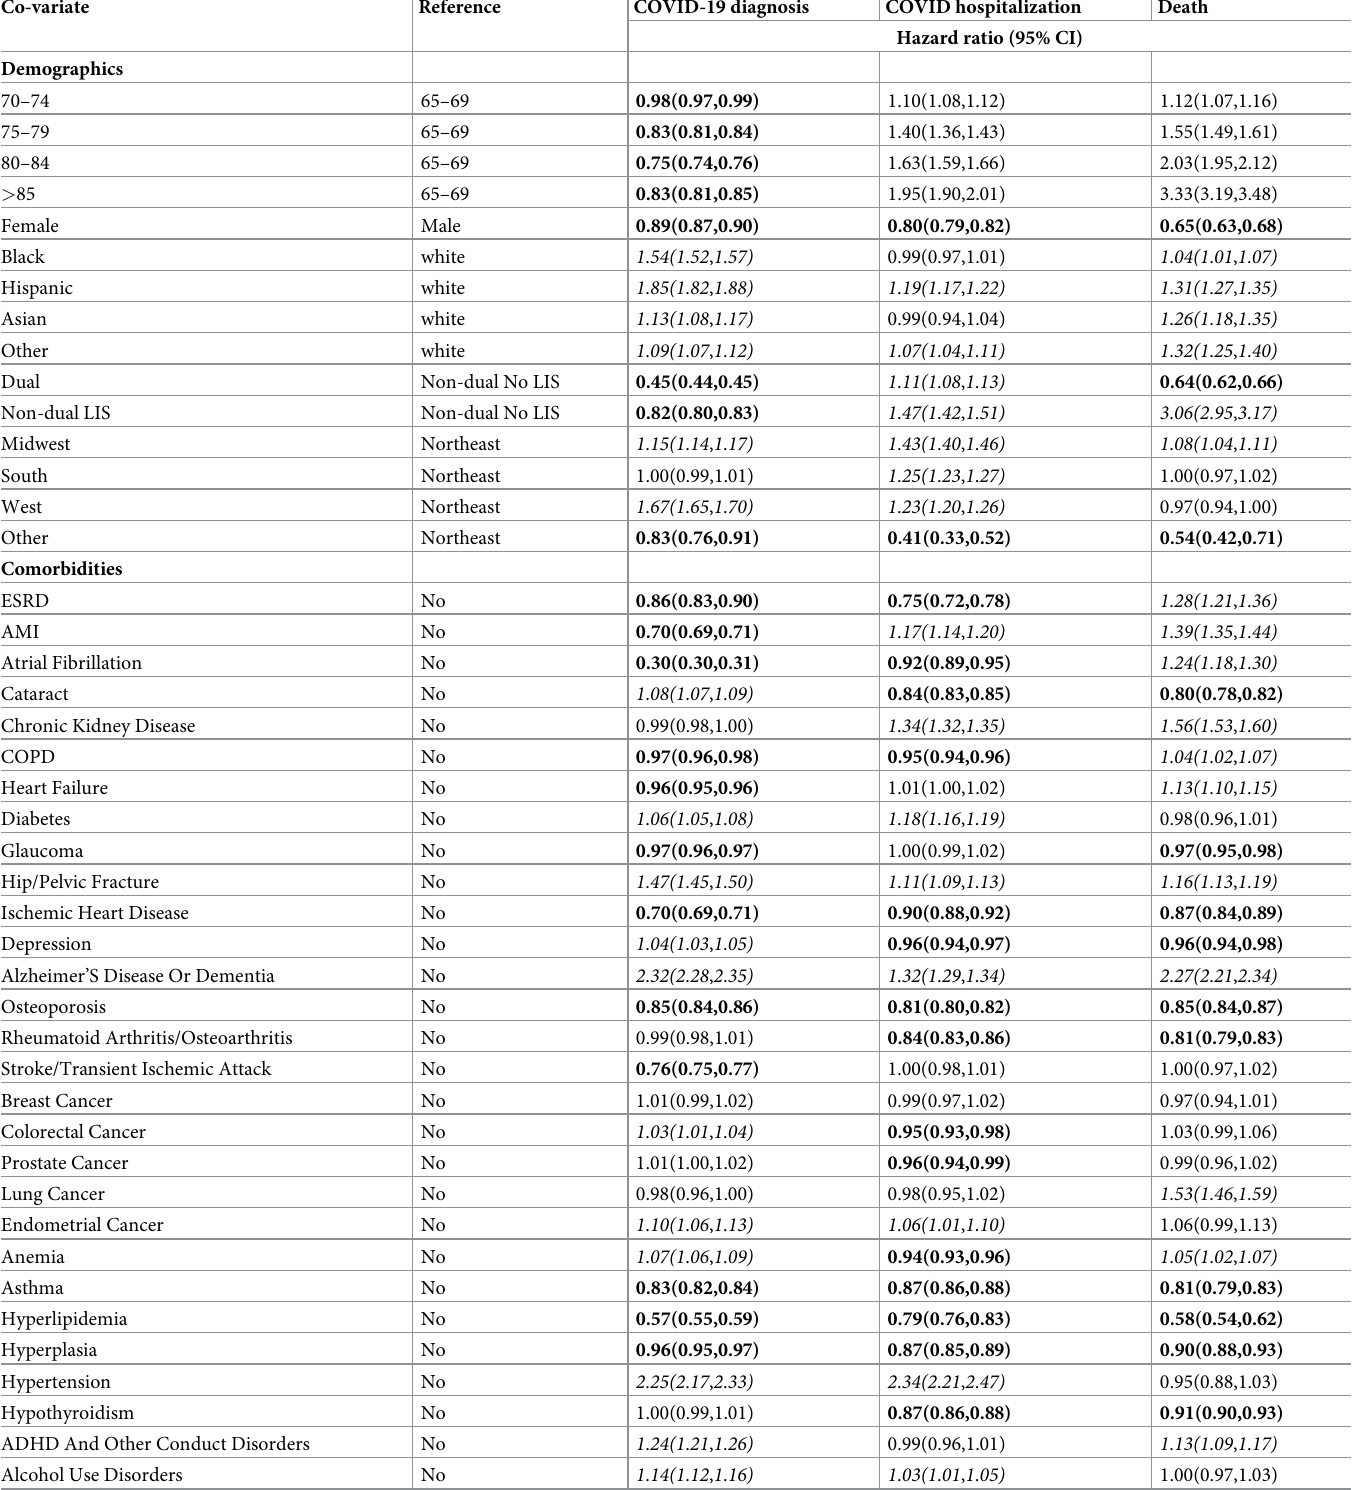
Table 4. Effect of non-drug covariates on Covid-19 diagnosis, Covid-19 hospitalization and death (drug-related covariates are listed in Table 3).